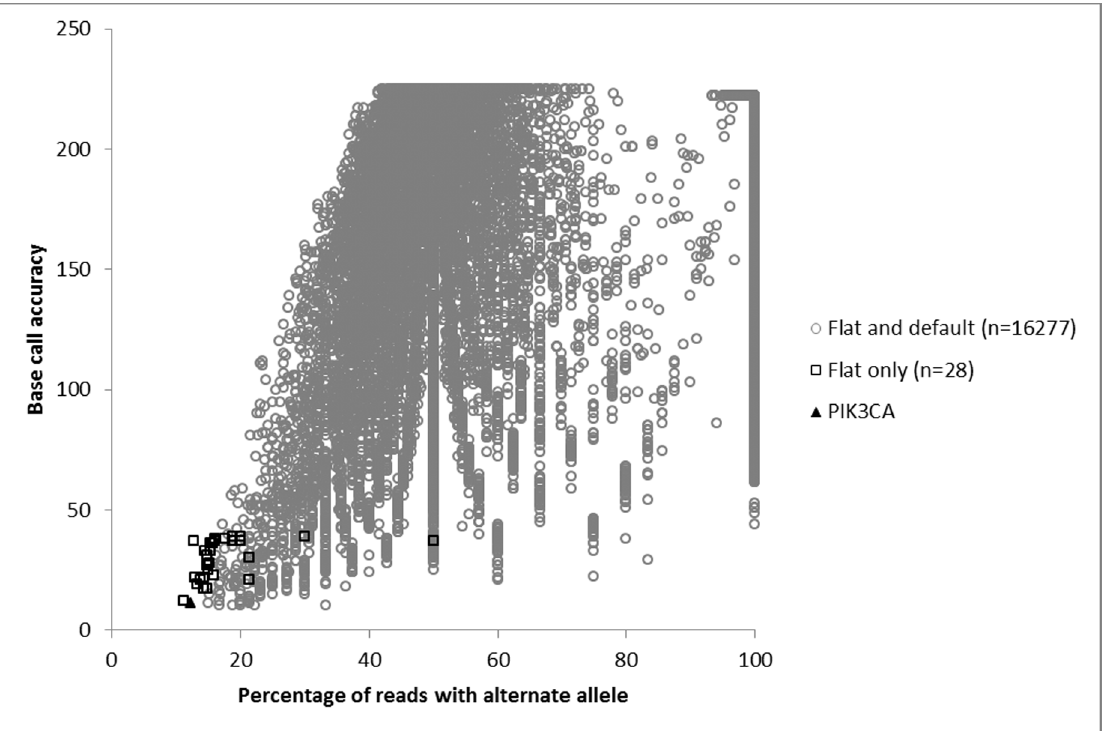
Figure 1. Variants identified in sample 2 by the full and flat AFS models including the mosaic post zygotic variant in PIK3CA.